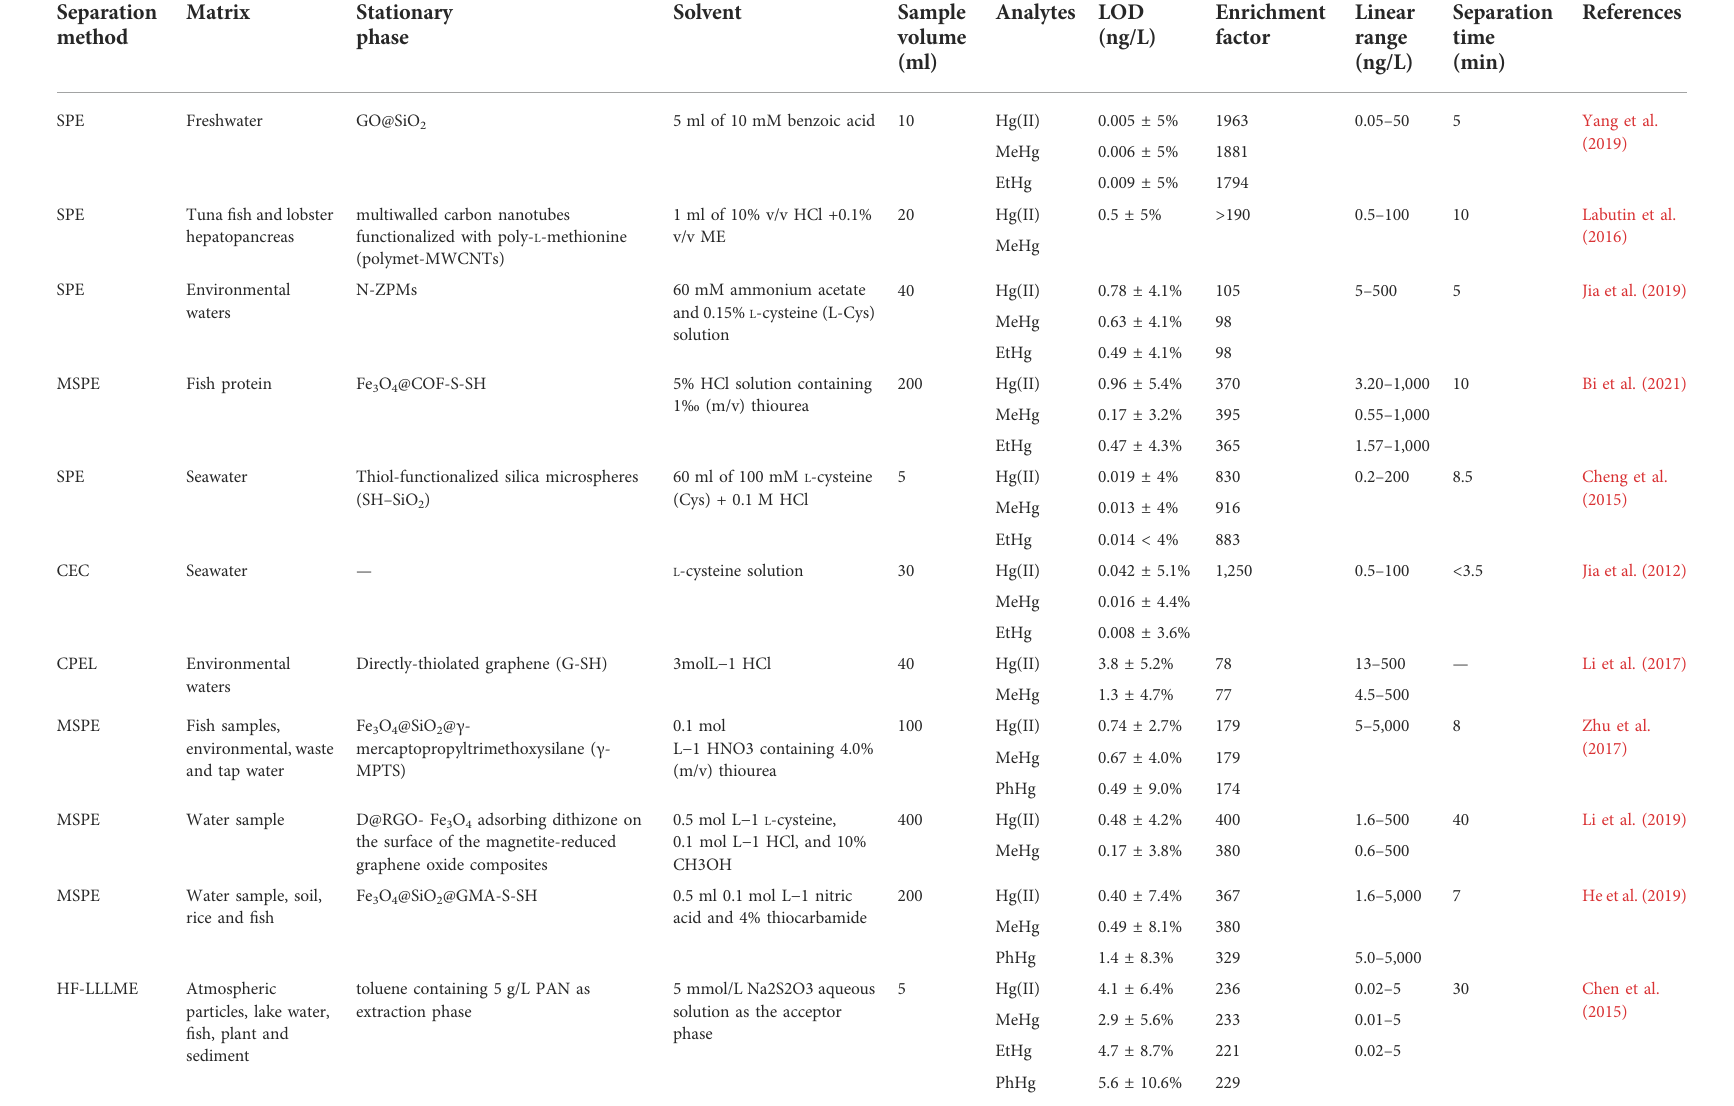
TABLE 1 Preconcentration approaches adopted for the determination of low concentrations of mercury